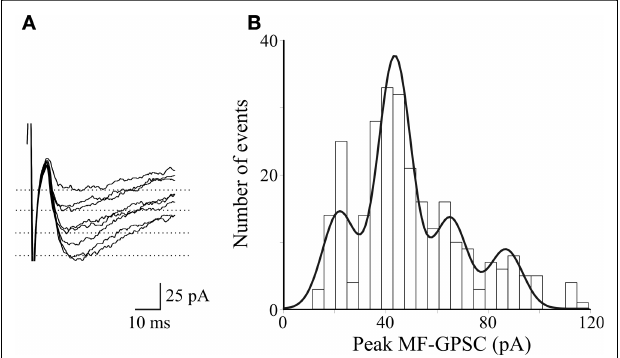
FIGURE 6 | Amplitude distribution of stimulus evoked MF-GPSCs under conditions of low quantal content (extracellular Ca 2 + /Mg 2 + ratio 0.16). (A) Selected events, excluding failures, recorded from a P3 CA3 pyramidal neuron at − 60 mV. (B) Histogram of GPSCs peak amplitude (289 events excluding failures) for the cell shown in A was fi tted with the sum of four Gaussian functions with means of 21.7, 43.5, 65.2, 86.9 pA, respectively and a fi xed SD of 6.5 pA; bin size = 5